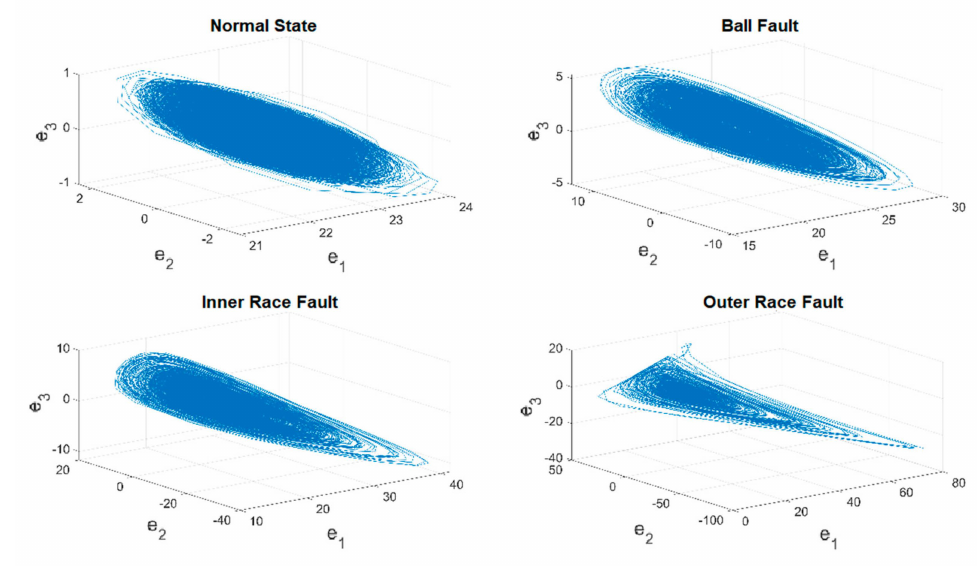
Figure 8. 3D phase portraits of converted data in the chaotic